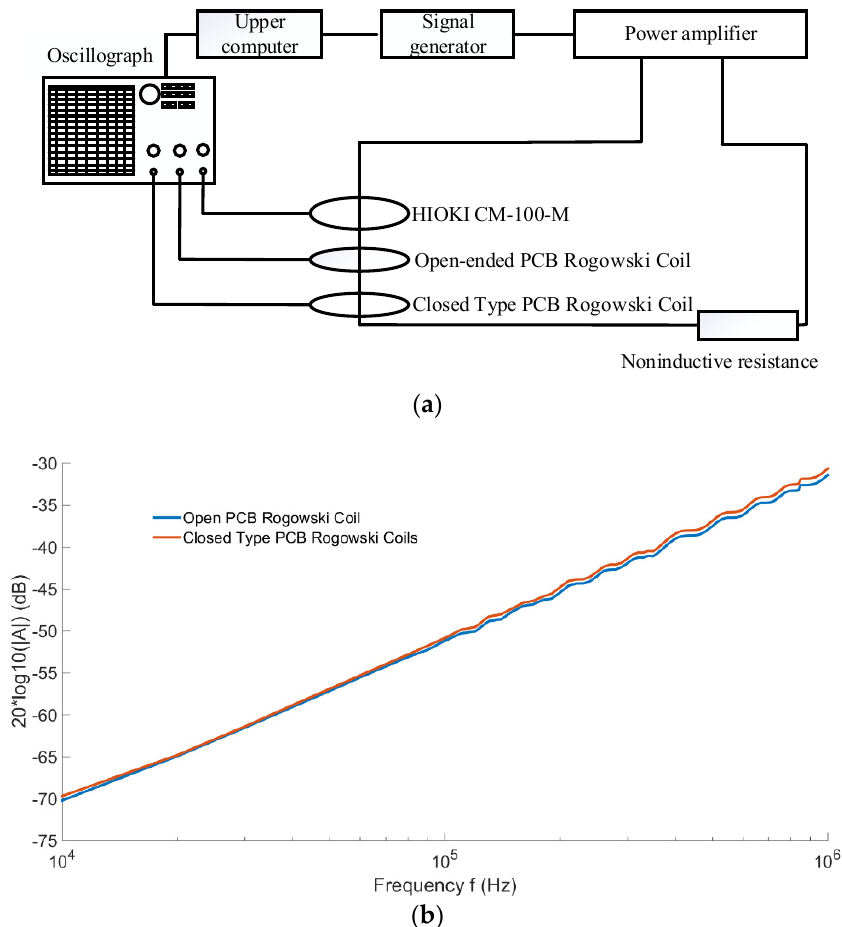
Figure 13. Effect of Opening on PCB Rogowski Coil. ( a ) Rogowski coil probe test platform; ( b ) Measured amplitude-frequency response curve of Rogowski coil.